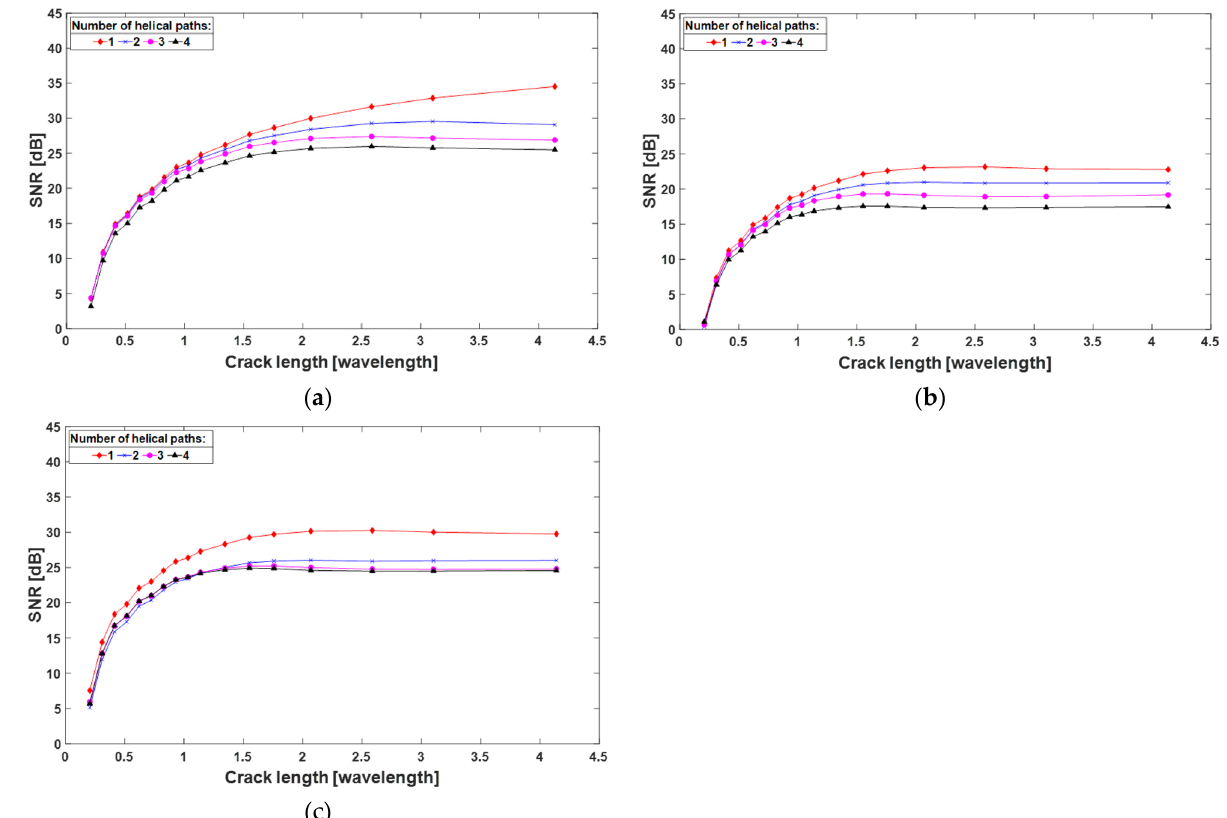
Figure A6. Coherent SNR vs. true crack length from ( a ) CSM, ( b ) PWI and ( c ) TFM reconstructions. Based on FE simulations of 50% through wall thickness crack.